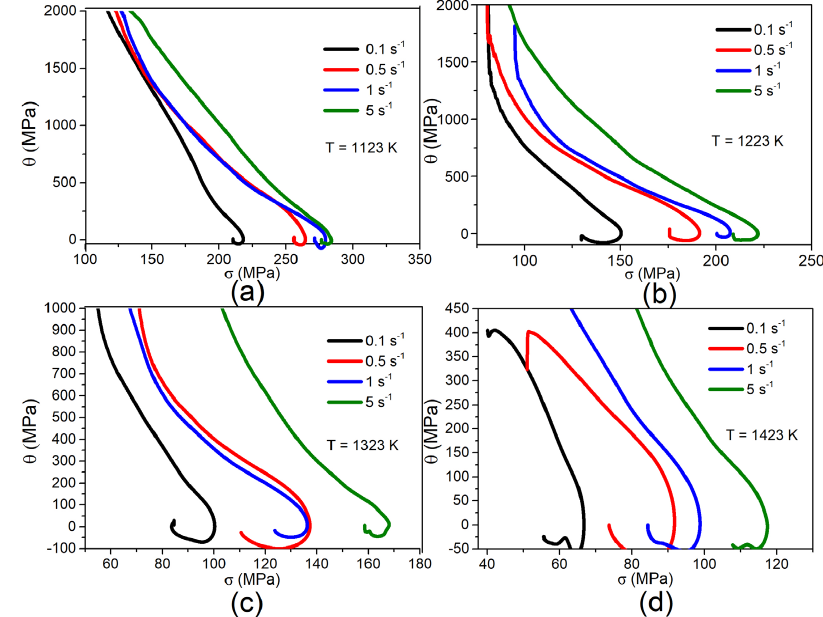
Figure 7. θ-σ curves on different temperatures and strain rates: (a) 1123 K; (b) 1223 K; (c) 1323 K; (d) 1423